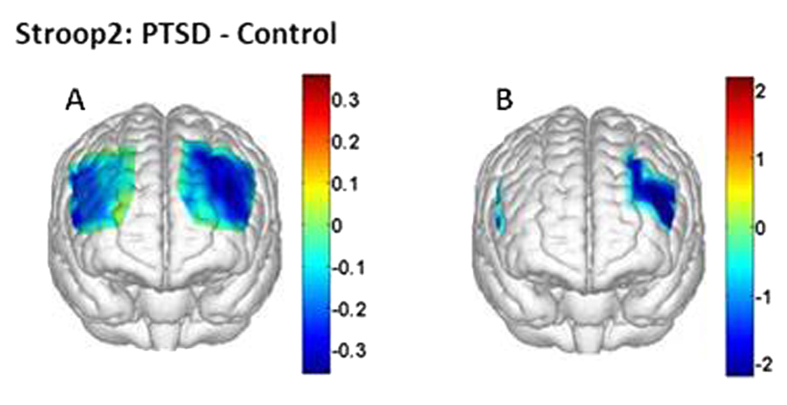
Topographic images of the prefrontal activations derived from HbO2, showing differences between the PTSD and control groups in response to Stroop2 (incongruent Stroop) tasks.(A) Group-averaged differences in activations or β-maps (in μM) between the two groups. (B) A t-map (p-value < 0.1; FDR corrected) showing the regions of significantly different activations and deactivations between the groups.